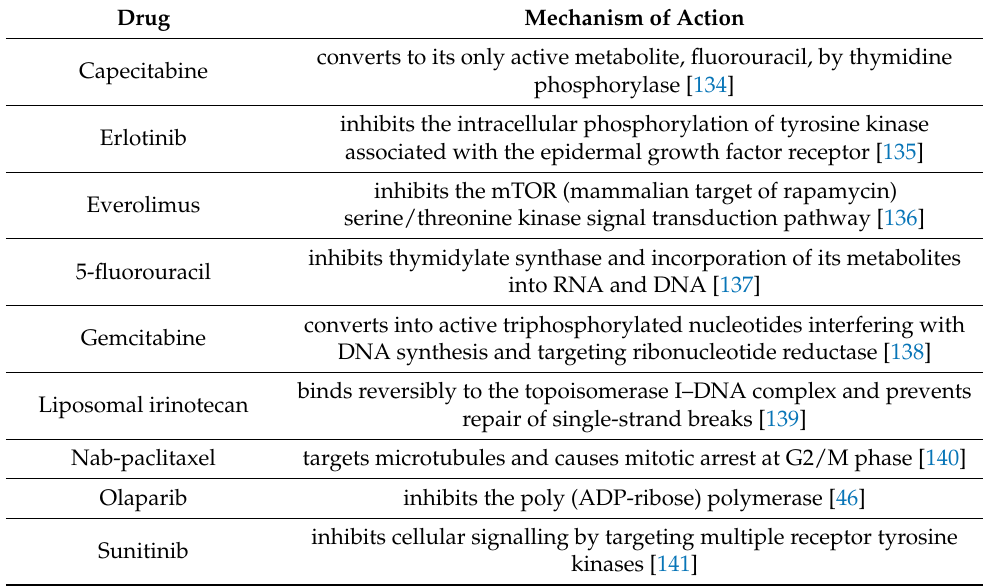
Table 2. Drugs approved by FDA for pancreatic cancer.